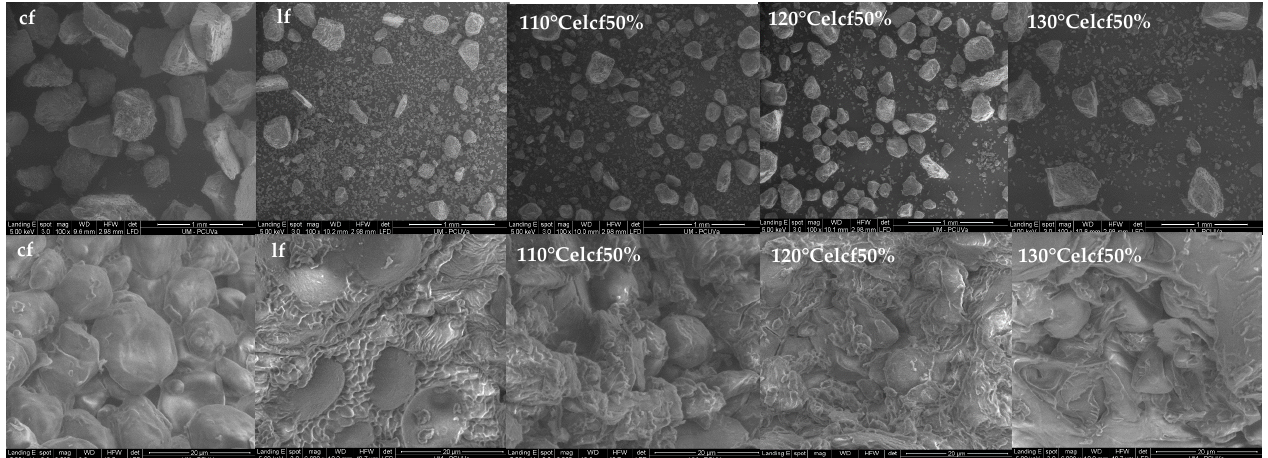
Figure 5. Scanning electron microscope (SEM) of native (corn and lentil) and blend lentil-corn extruded flours at different temperatures. Abbreviations: cf: corn flour; lf: lentil flour; elcf: extruded lentil (50%)-corn